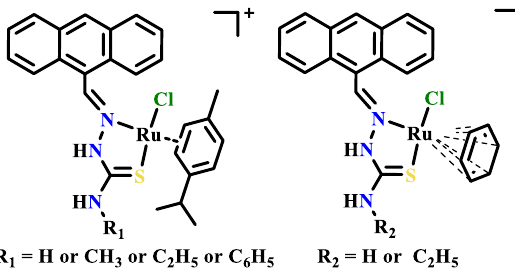
Figure 46. Organo-Ru(II) complexes of 9-anthrachydrazone with N -(methyl/ethyl/phenyl)-substi- tuted thiourea as side chains, as reported by Floyd A. Beckford ’ s